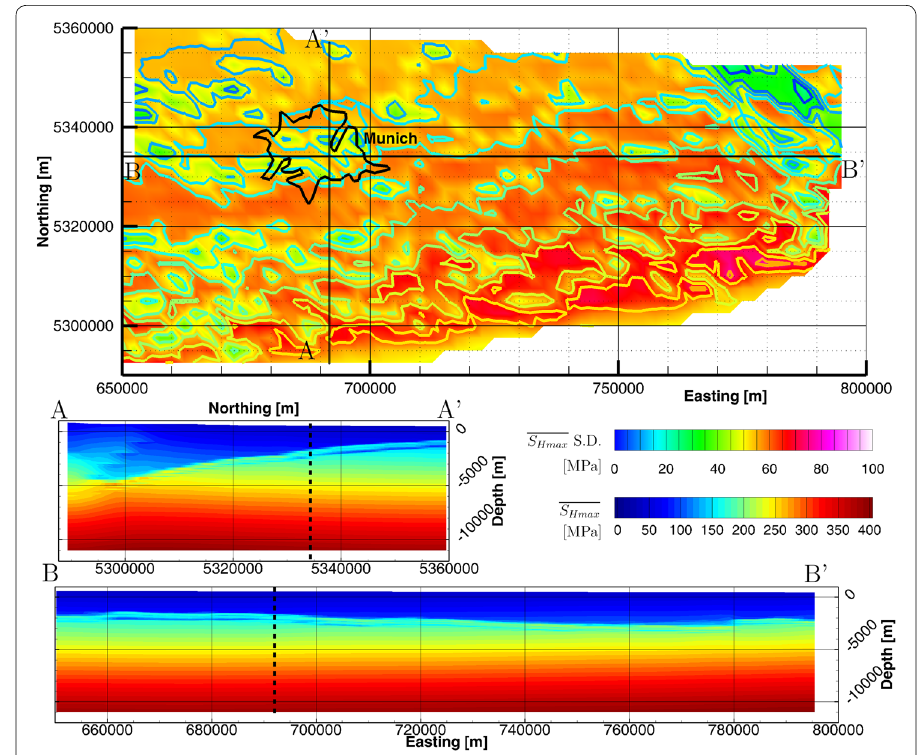
Fig. 5 Average magnitude and standard deviation of S Hmax . Same description as in Fig. 4